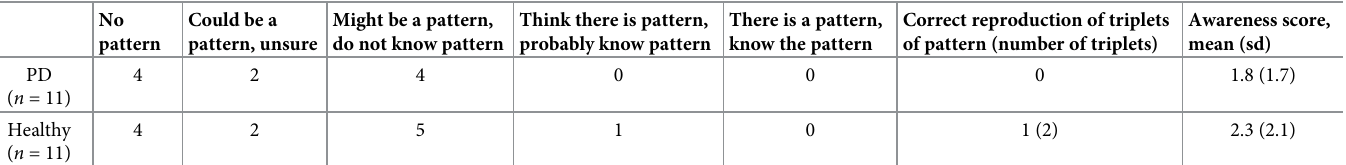
Table 2. Awareness of the sequence in the